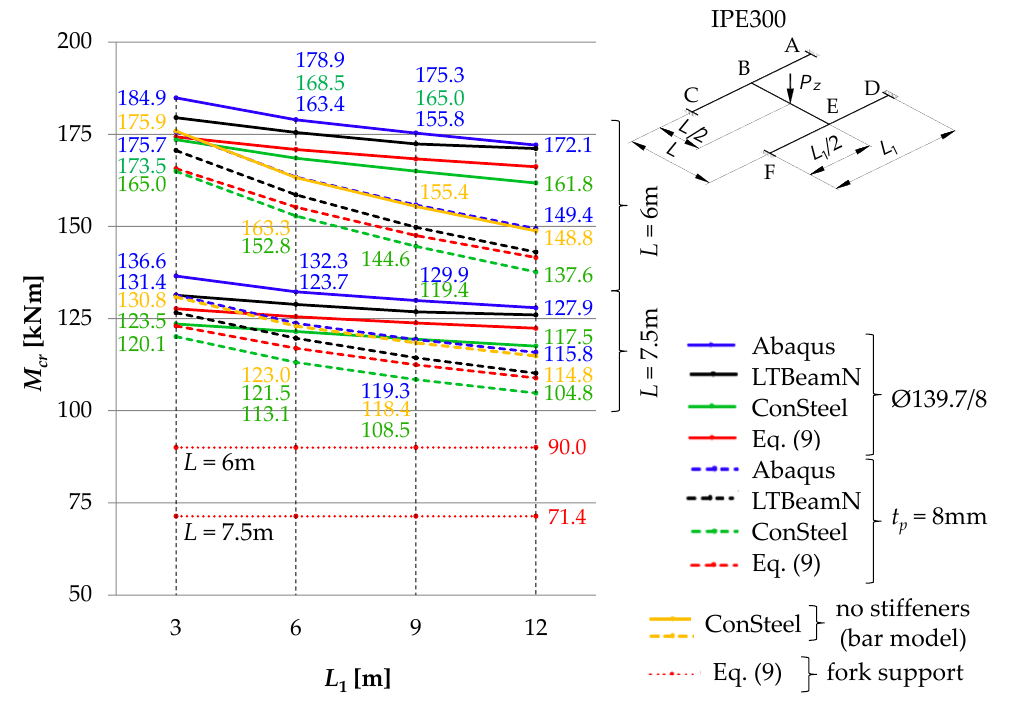
Figure 13. M cr of the critical (main) beam B–E with concentrated force as a function of the span L 1 of the supporting beams A–C and D–F.